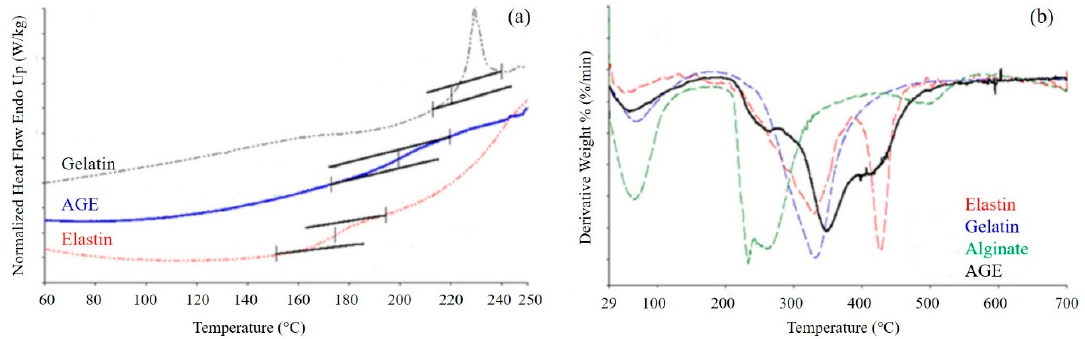
Figure 5. ( a ) Differential scanning calorimetry (DSC) thermograms of gelatin, elastin, and AGE blend. Inflections in the curves indicate a glass transition event; ( b ) Derivative curves obtained by thermogravimetric analysis of AGE blend and pure components. Peaks in the curves indicate events of weight loss.